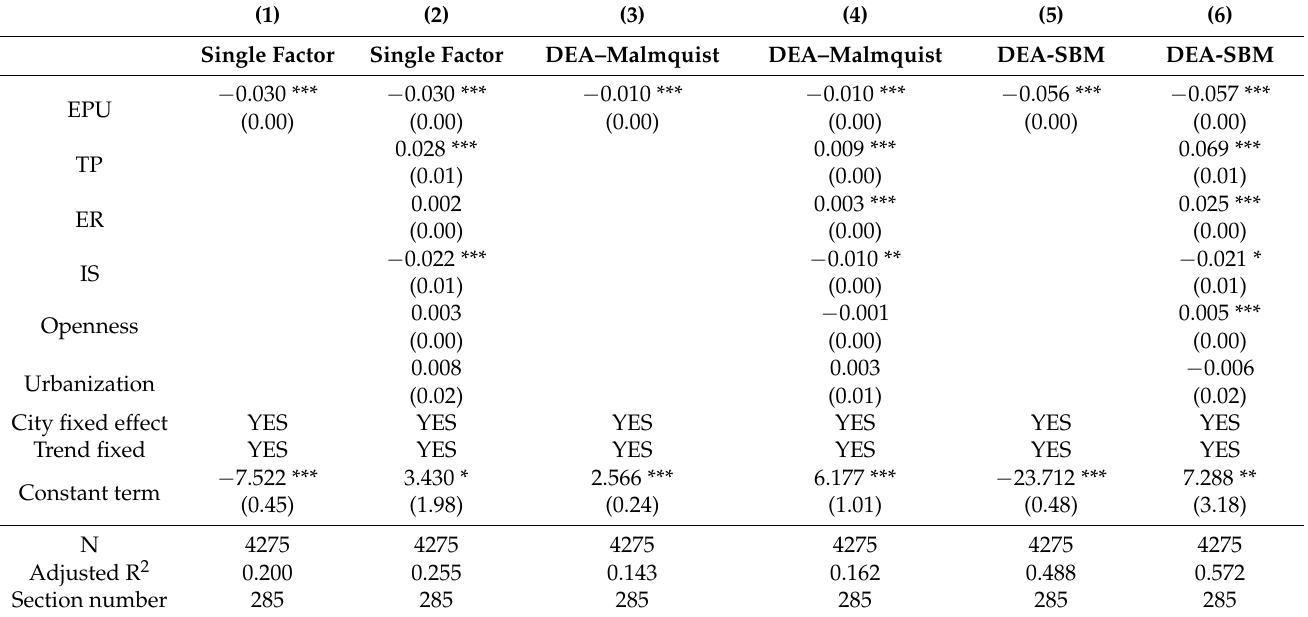
Table 3. Benchmark regression